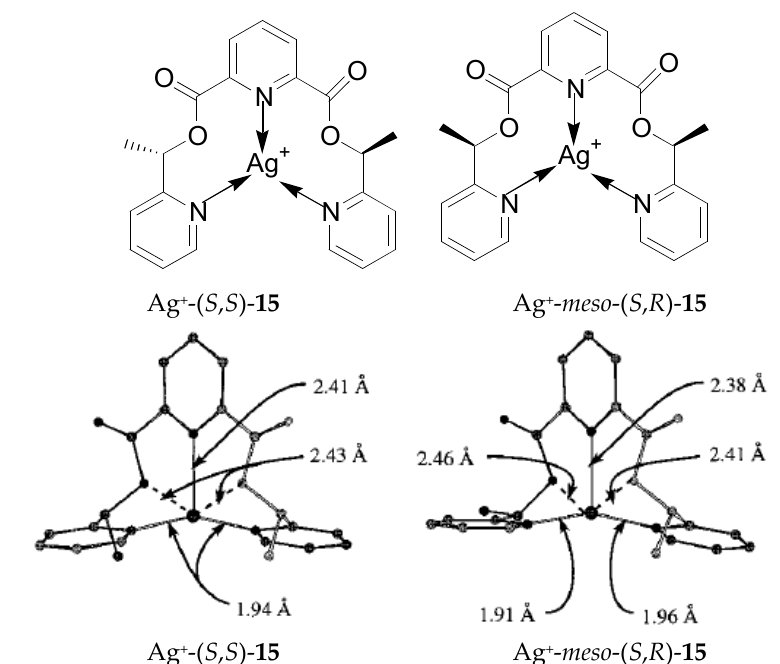
Figure 9. Ag + complexes of ligands whose Ag + -specificities are controlled by stereochemistry and optimized structures of such complexes. Reprinted with permission from Reference [54]. Copyright (1998) American Chemical Society.